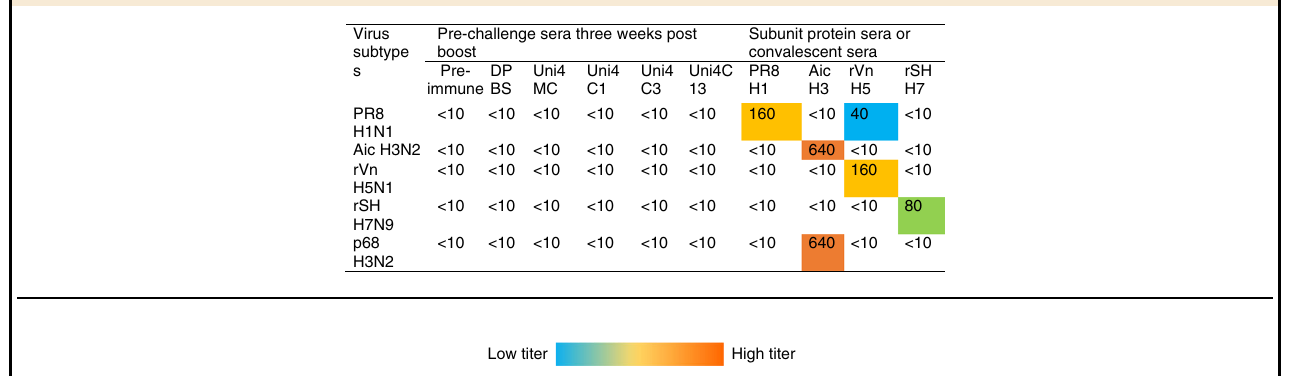
Table 1 HAI titers of immune sera prior to and post challenges